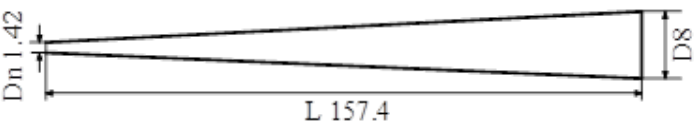
Figure 4. Experimental model of high-speed vehicle.